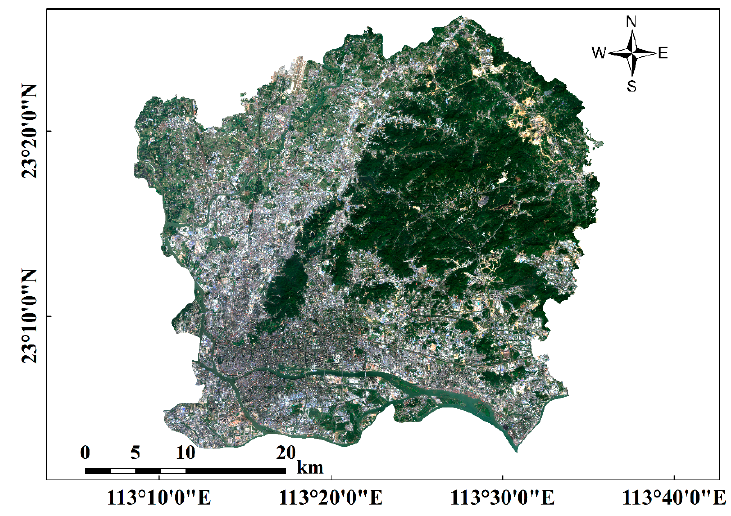
Figure 1. Sentinel-2A RGB image (R: band 4, G: band 3, B: band 2) of the study area.